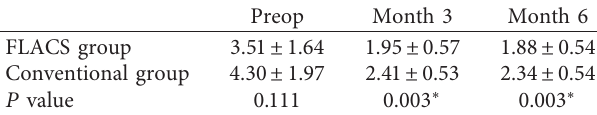
Table 4: Pre- and postoperative OSI between the two groups at different time